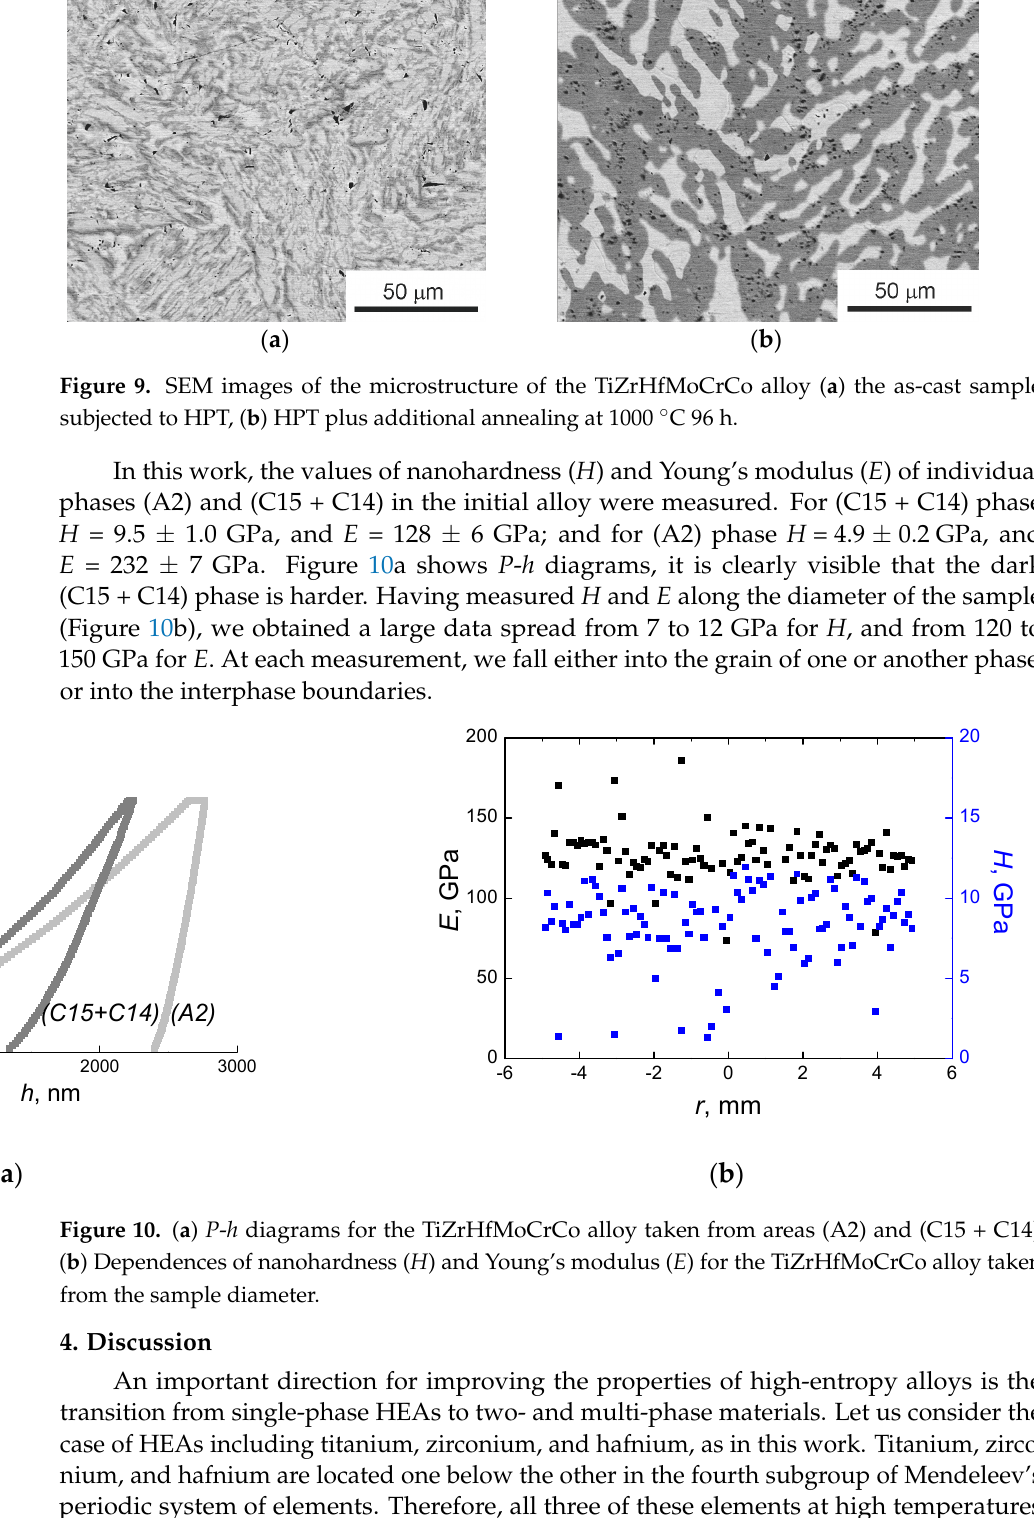
Figure 8. Diffraction patterns for the TiZrHfMoCrCo alloy in the as-cast state (black line) after HPT (green line) and after HPT plus annealing at 1000 °C 96 h (red line).